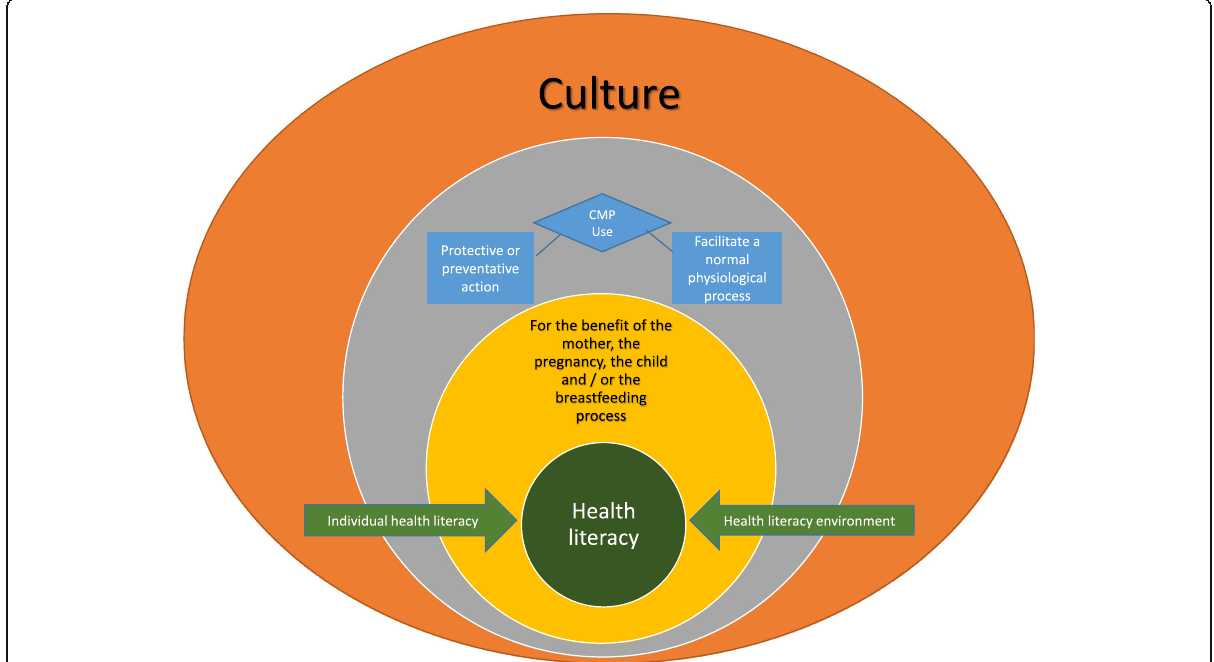
Fig. 5 Health literacy and women ’ s decisions to use CMPs in pregnancy and lactation, within the overarching influence of culture, modified from Parker [66] and the Australian Commission on Safety and Quality in Health Care ’ s working definition of health literacy